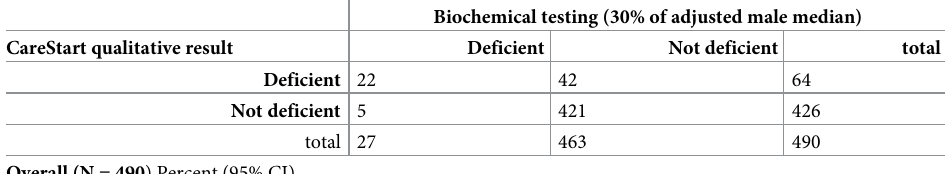
Table 4. Concordance between biochemical testing and qualitative CareStart results, New Halfa and Khartoum